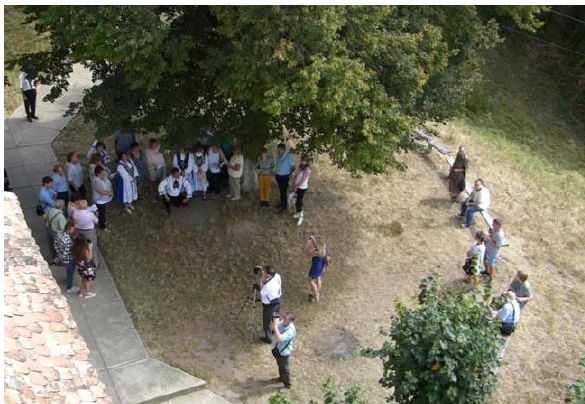
Figure 3. Saxon people singing a celebrating song in front of Alma Vii Fortified Church.